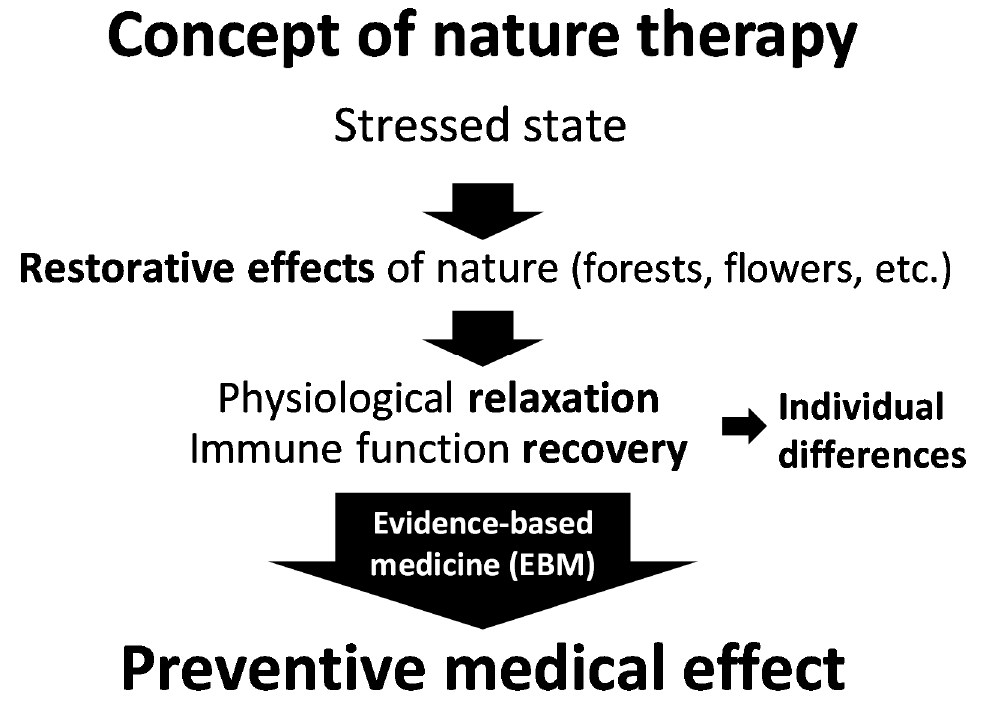
Figure 1. Concept of nature therapy [12].